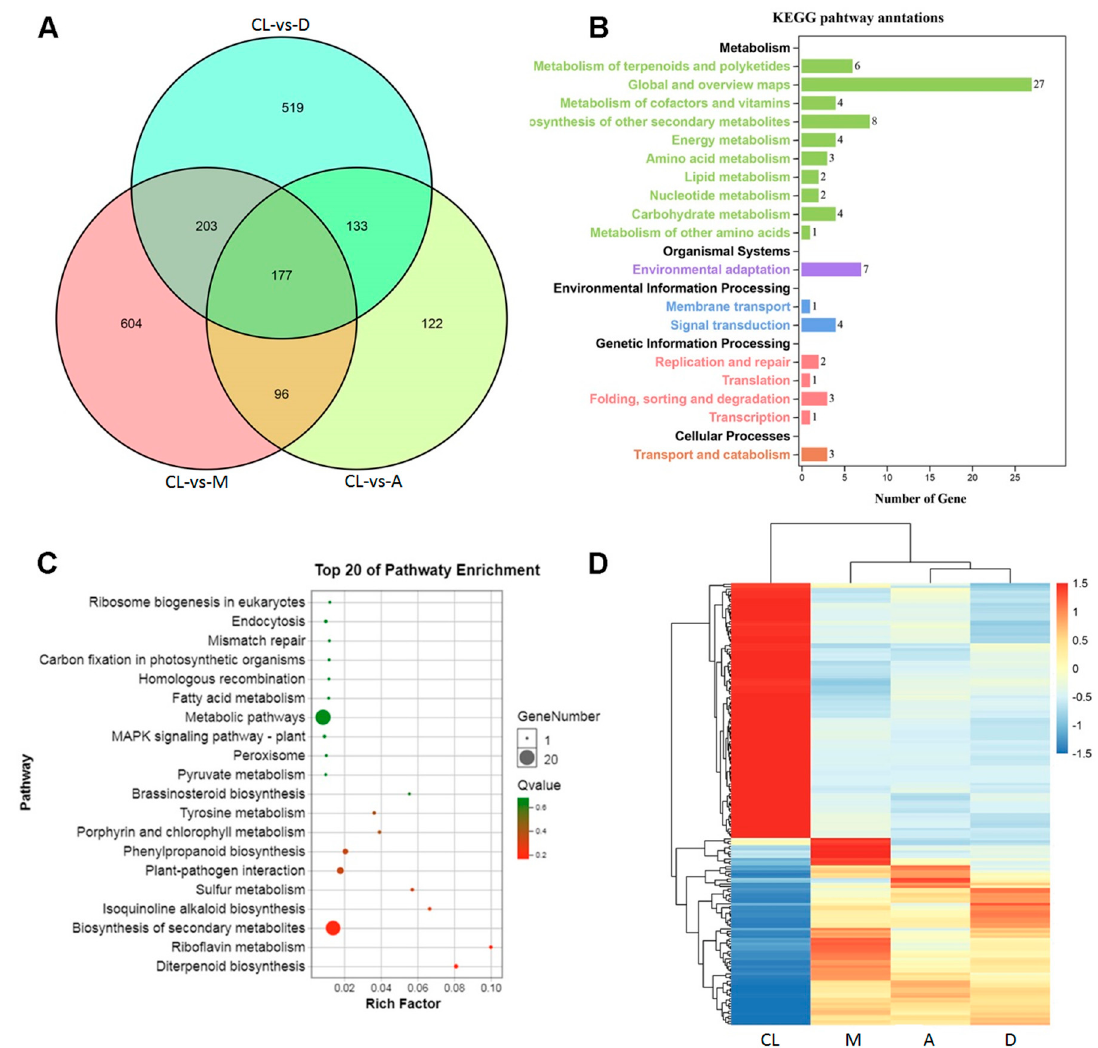
Figure 6. Common DEGs under fluctuating light treatments. ( A ) Venn diagram of common genes detected in three DL treatments compared with the CL treatment. ( B ) KEGG pathway enrichment for the 177 common genes. ( C ) Top 20 enriched KEGG pathways. ( D ) Hierarchical clustering of common genes based on normalized FPKM values under the four tested light regimes. Blue indicates lower expression, and red indicates higher expression.